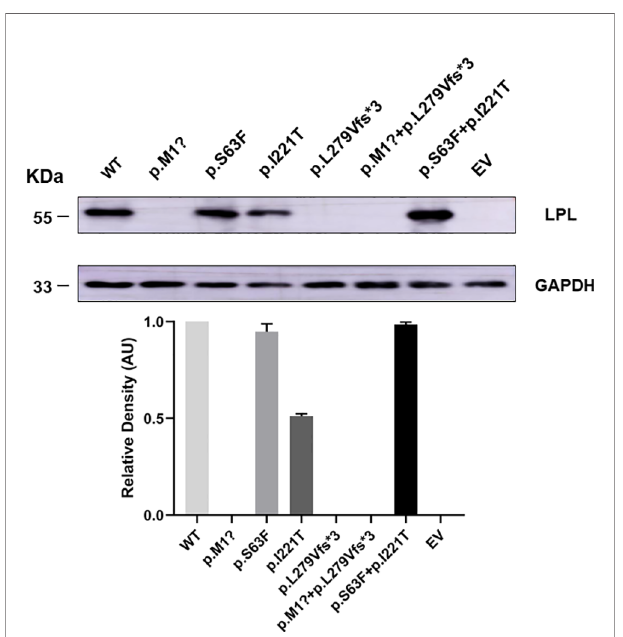
FIGURE 5 | HEK 293T/17 cells transiently transfected showed a reduction in the production of LPL variants. HEK293T/17 cells transfected with the p. M1? mutation, p. L279Vfs*3 mutation, or p. M1? and p. L279Vfs*3 mutation showed virtually no protein in the cell lysate (p<0.01). Compared with cells transfected with the plasmids containing the pcDNA3.1- LPL -WT, there was no signi fi cant difference in the amount of protein reduction produced by the cells transfected with the p. S63F mutation or the two variants (p. S63F and p. I221T), but protein synthesis was reduced by 48.33 ± 1.78% in cells transfected with the p. I221T variant (p<0.01). Abbreviations: EV, empty vector; WT, wild type; LPL, lipoprotein lipase.